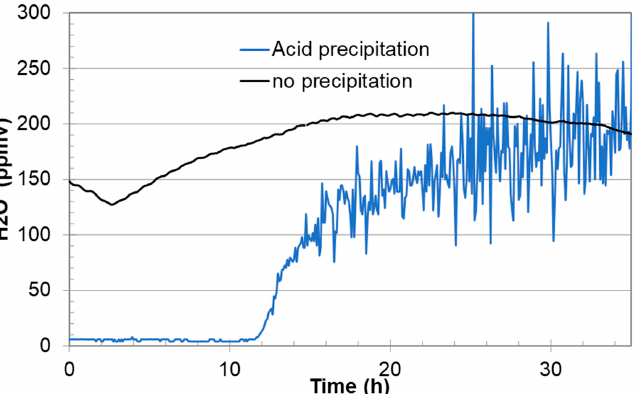
Figure 7. Water analysis from two experiments. The blue line is from an experiment where the exhaust CO 2 was saturated with sulfuric acid (after 11 h), which precipitated in the heated gas regulator and introduced significant fluctuations in the water content. The black line is from another experiment without sulfuric acid.